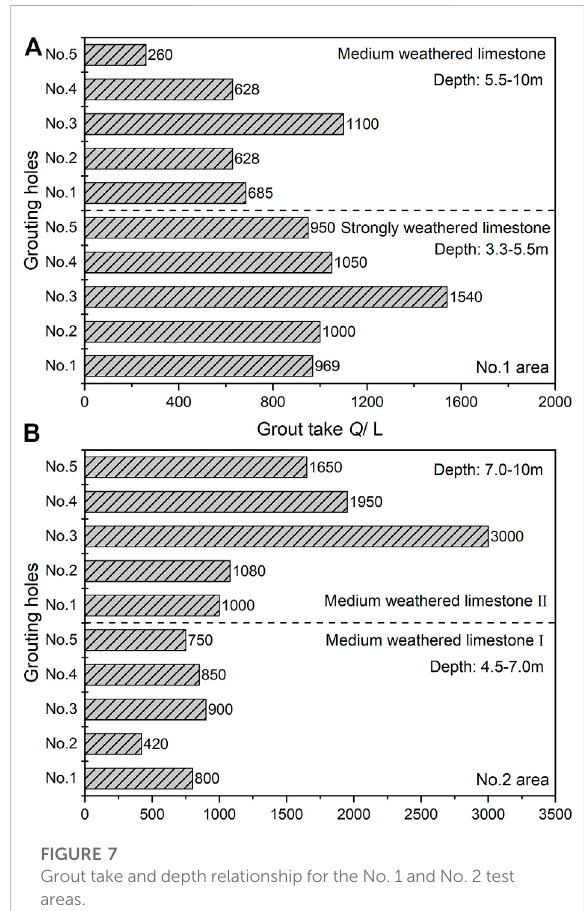
FIGURE 7 Grout take and depth relationship for the No. 1 and No. 2 test